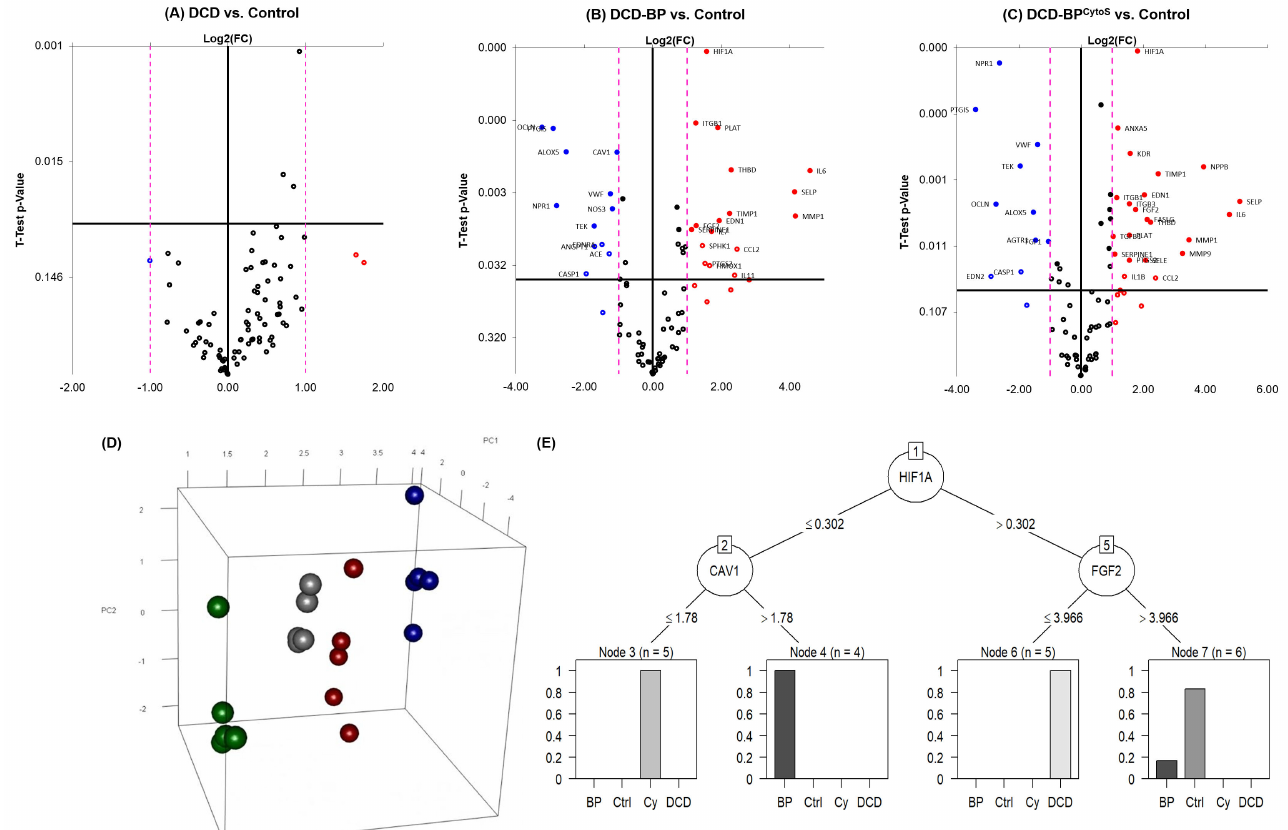
Figure 7. ( A ) Volcano plots for regulated genes of the group DCD, ( B ) DCD-BP, and ( C ) DCD- BP CytoS compared to Control. ( D ) Principal component analysis on the Borruta preselected variables, ( E ) Decision tree to show key regulated genes, which allow differentiation between groups. BP: blood perfusion. BP CytoS or Cy: blood perfusion with an integrated cytokine adsorption device. Crtl: control. DCD: donation after circulatory